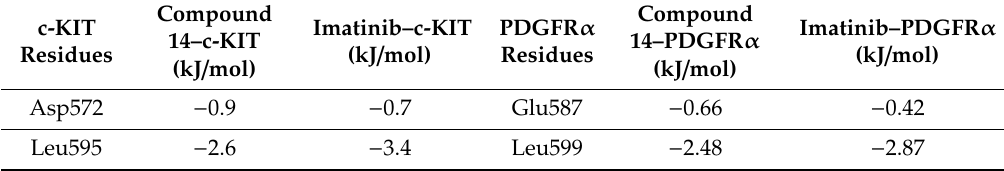
Table 3. Residues that showed a high contribution to the total binding energy during the MD simulations of Compound 14 – c-KIT , imatinib–c-KIT , Compound 14 – PDGFR α and imatinib–PDGFR α . The energy values of the residues are given in kJ /